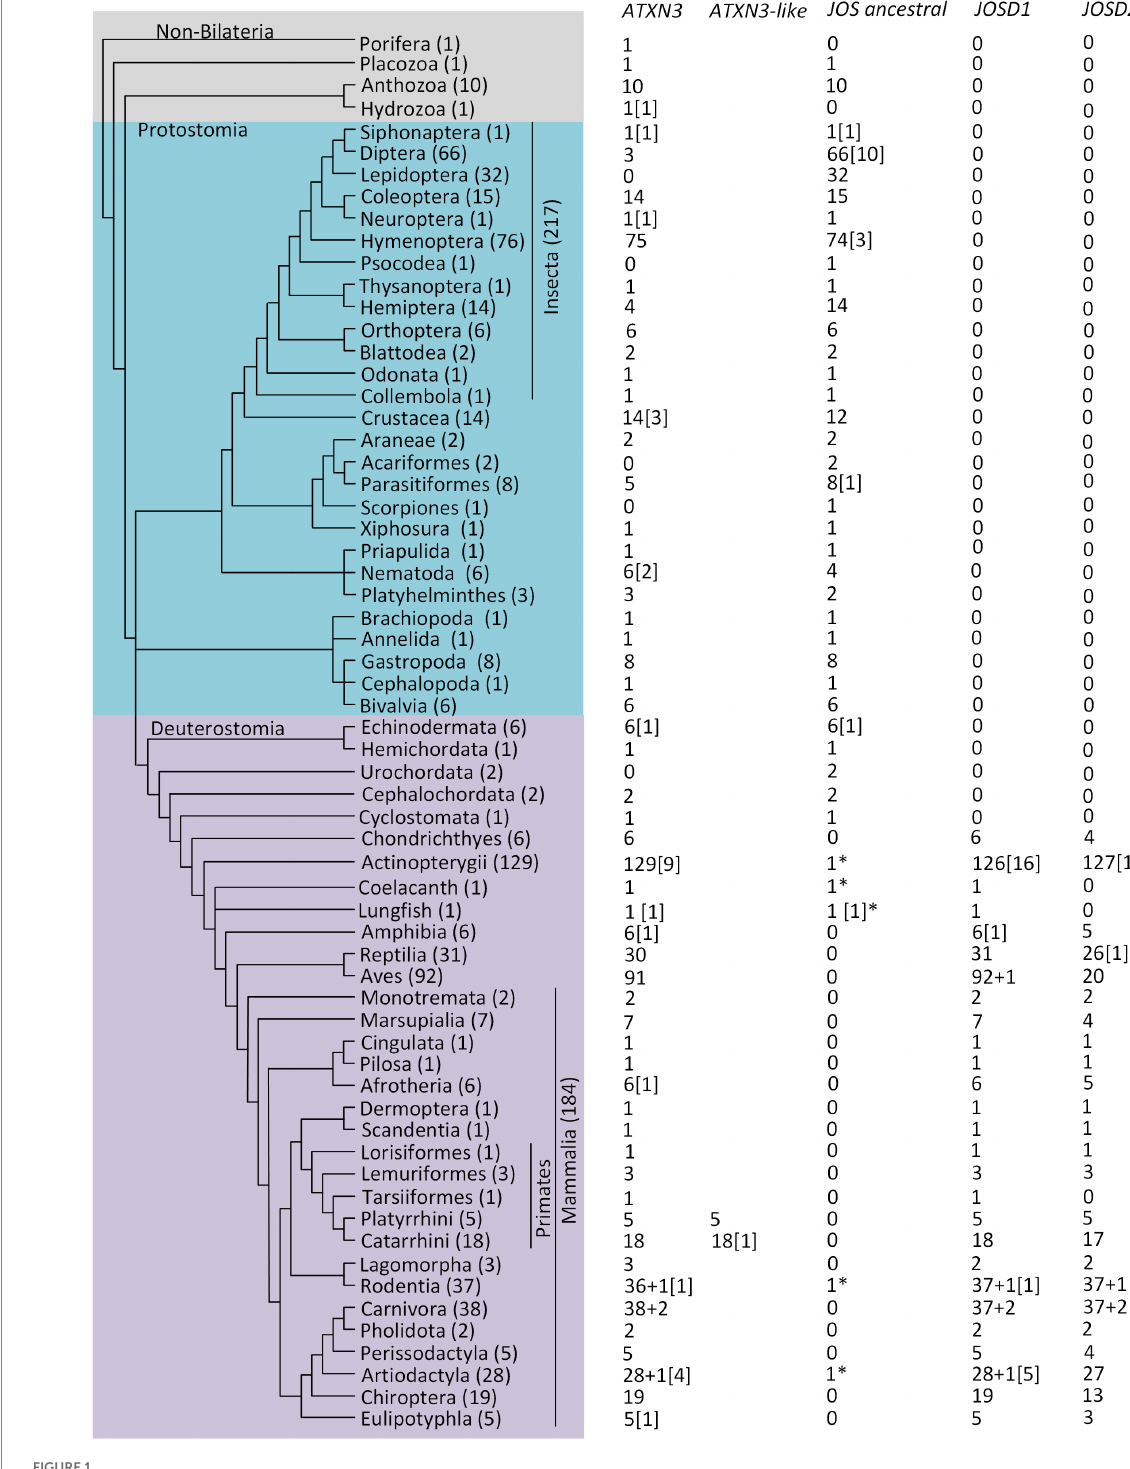
FIGURE 1 The ataxin-3 and Josephin lineages evolution across the animal kingdom, based on 747 species. The cladogram topology is depicted as in the Tree of Life web project (Maddison et al. 2007). For each taxomomic group, the number of genomes analyses is indicated within brackets after the taxonomic group. Numbers under the gene names indicate the number of genomes where the gene has been identified. Gene duplications are indicated within square brackets. Stars represent likely phylogenetic inferences